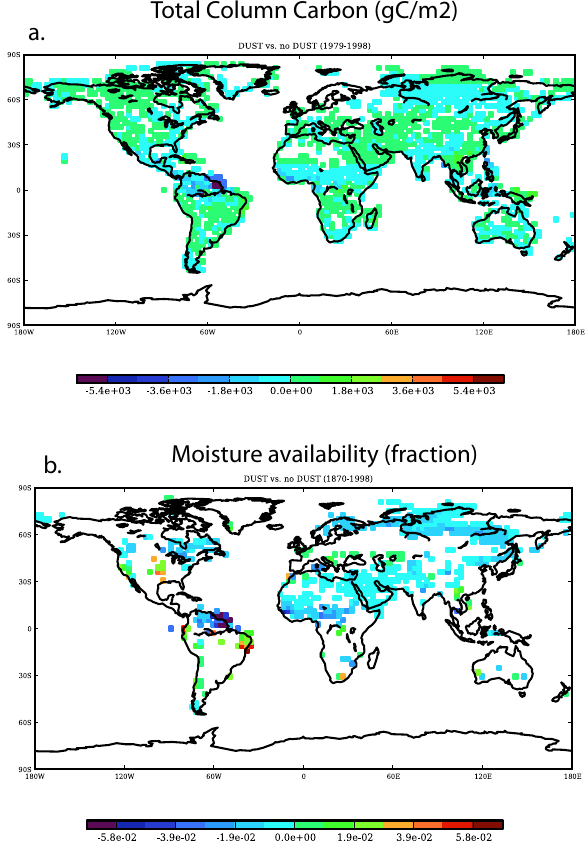
Fig. 9. The change in total land column carbon inventory because of dust variations and their impact on radiative (averaged over 1979– 1998) (a) , and the change in moisture availability for growth (aver- aged over 1870–1998) due to dust (simulations including dust radia- tive forcing minus simulations not including dust radiative forcing. An increase in the latter value indicates that the plants have more moisture available to them for